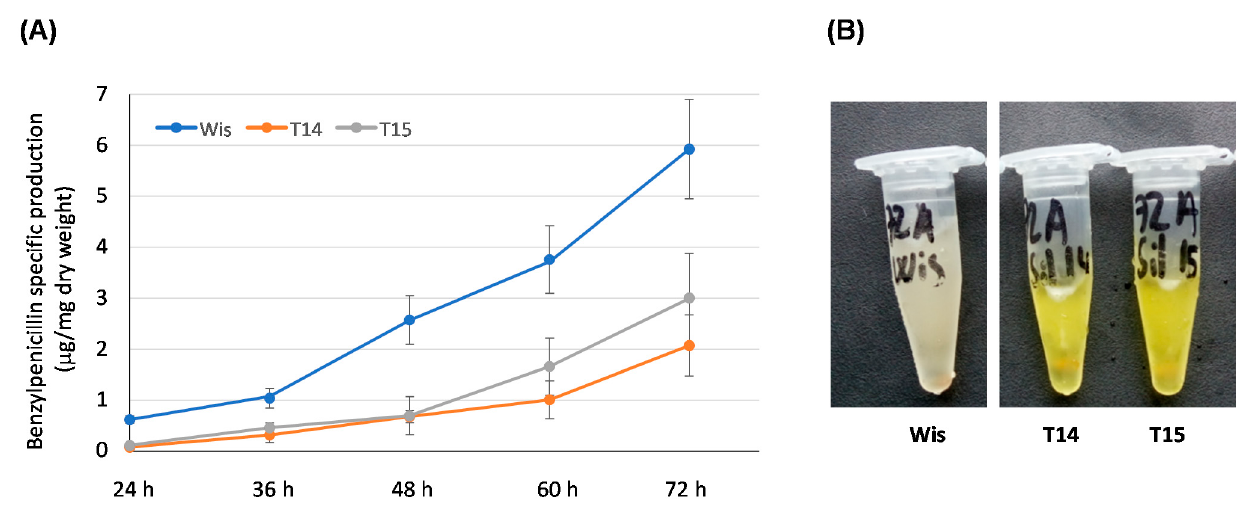
Figure 5. Secondary metabolism in knock-down transformants T14 and T15. ( A ) Benzylpenicillin specific production ( μ g/mg dry weight) of the control strain Wisconsin 54-1255 (Wis) and knock- down transformants T14 and T15 grown in defined medium. Results correspond to the mean ± SD from three different experiments carried out in duplicate. ( B ) Supernatants obtained after 72 h of growth from cultures of the control strain Wisconsin 54-1255 (Wis) and knock-down transformants T14 and T14 in defined medium. Note the yellow-orange color of the knock-down transformants.